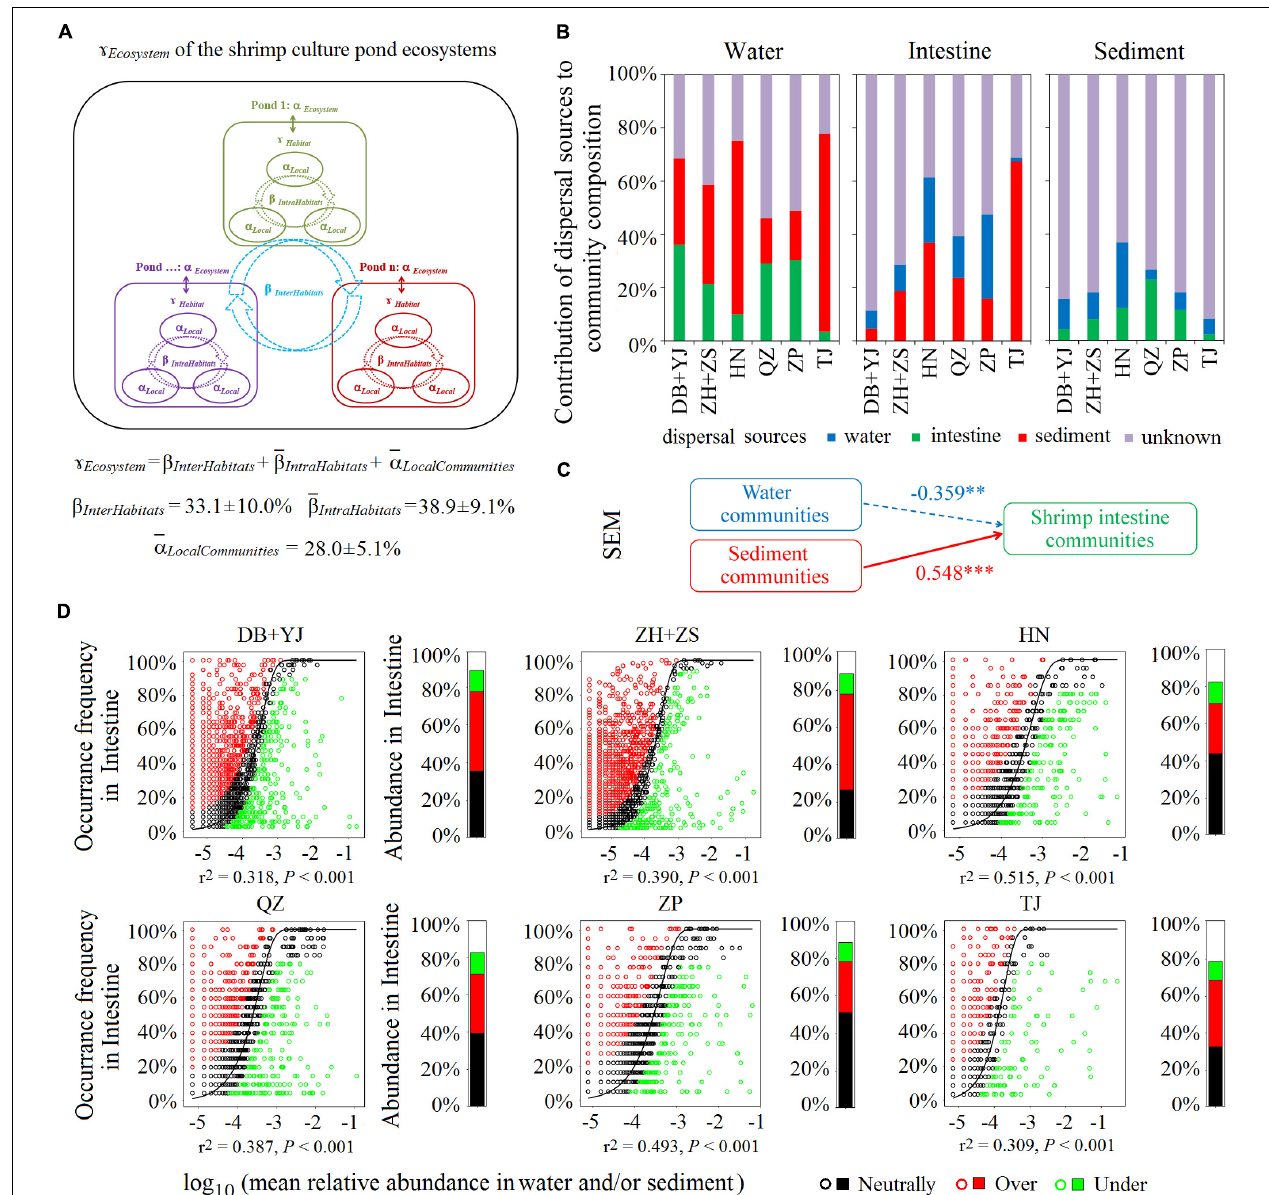
FIGURE 3 | The contribution of microbial communities in water, shrimp intestine, and sediment habitats to the SCPE metacommunity of six regions. (A) Multiscale hierarchical partitioning of microbial diversity. (B) SourceTracker analysis of contributions of water, shrimp intestine, and sediment source communities to each other’s communities. (C) The SEM shows environmental community drivers of shrimp intestinal microbiota in the SCPE. The directed graph of SEM, and the goodness-of-fit (GoF) statistic value was 0.626. Each box represents an observed variable or latent variable. Path coefficients are reflected in the width of the arrow with solid and dashed arrows indicating significantly positive and negative effects, respectively. ∗∗∗ : P < 0.001, ∗∗ : P < 0.01. (D) The Sloan neutral model applied to shrimp intestine communities with their corresponding surrounding water and/or sediment communities as the sources. Stacked bar chart depicts the relative abundance of sequences in the neutrally distributed (black), overrepresented (red), and underrepresented (green) OTUs in shrimp